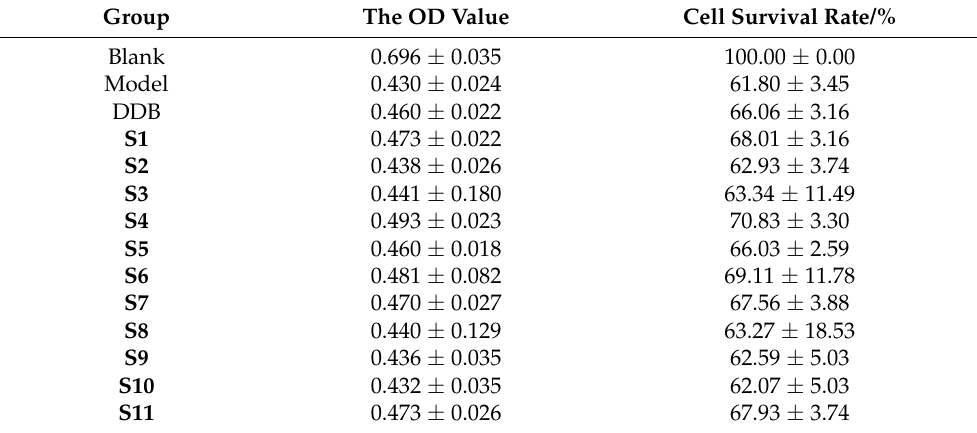
Table 3. The protective activity of the eleven batches test samples against CCl 4 -induced liver injury ( x ± s , n = 3).